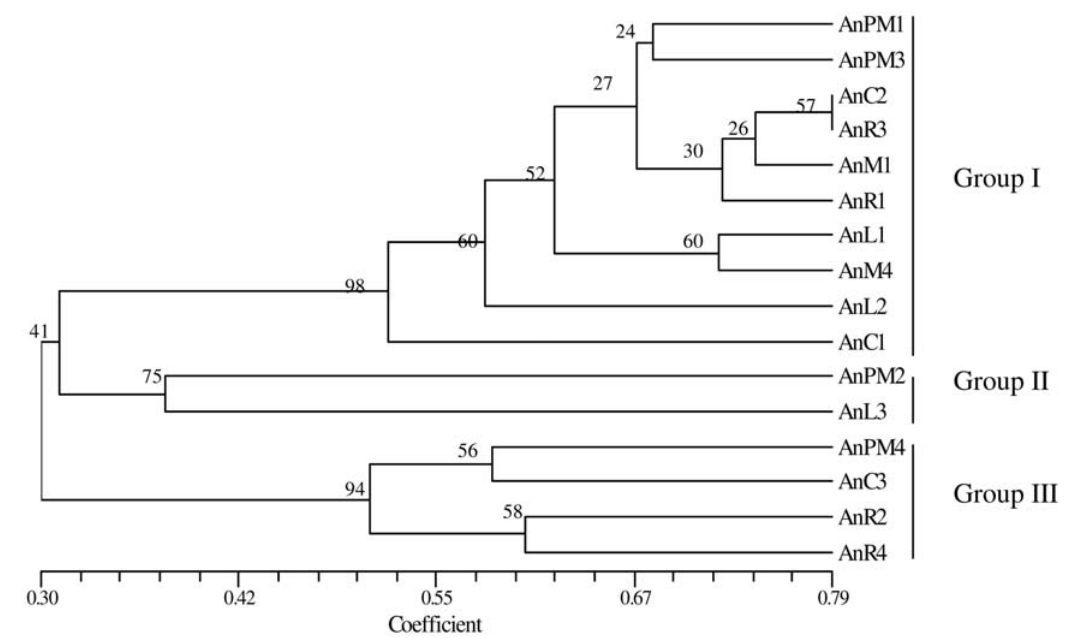
Fig. 2. Dendrogram of Aspergillus niger aggregate isolates, constructed using UPGMA with Jaccard’s similarity Index based on 28 RAPD primers. Number at branch points indicate support for isolates clustered to the right of the number, values are percent of bootstrap sample that exhibit the cluster (no number at branch indicates support less than 10%). The major clusters are indicated on right margin. Aspergillus niger aggregate isolates were collected from different crop fi elds: AnPM1, AnPM2, AnPM3, AnPM4 from pearl millet; AnC1, AnC2, AnC3 from cauli fl ower; AnR1, AnR2, AnR3, AnR4 from rice; AnL1, AnL2, AnL3 from lentil and AnM1, AnM4 from